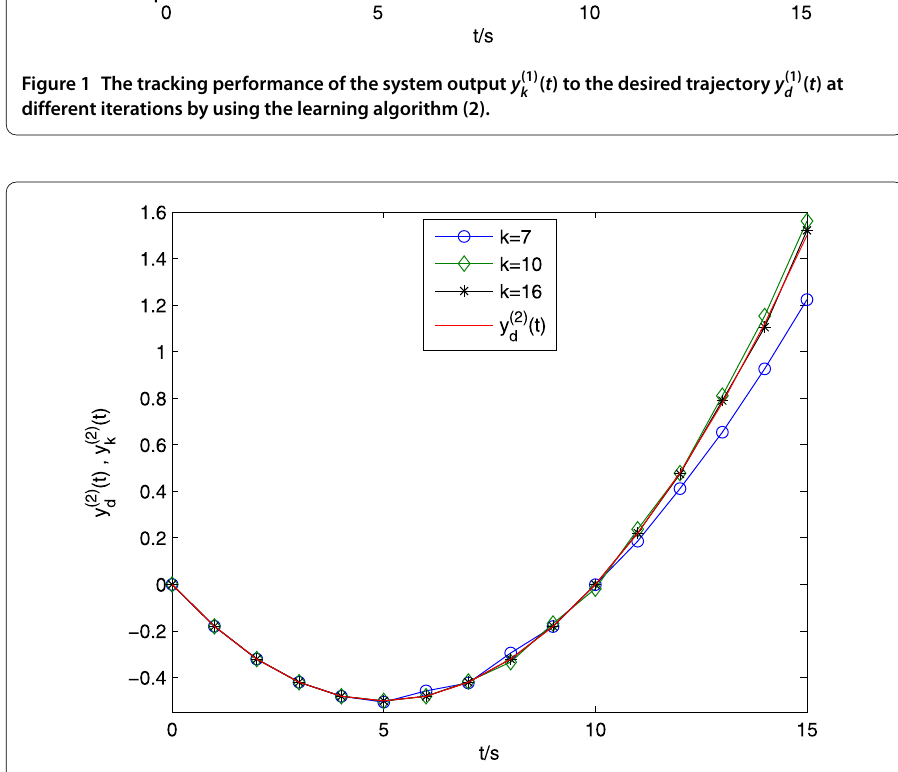
( t ) to the desired trajectory y (2) k